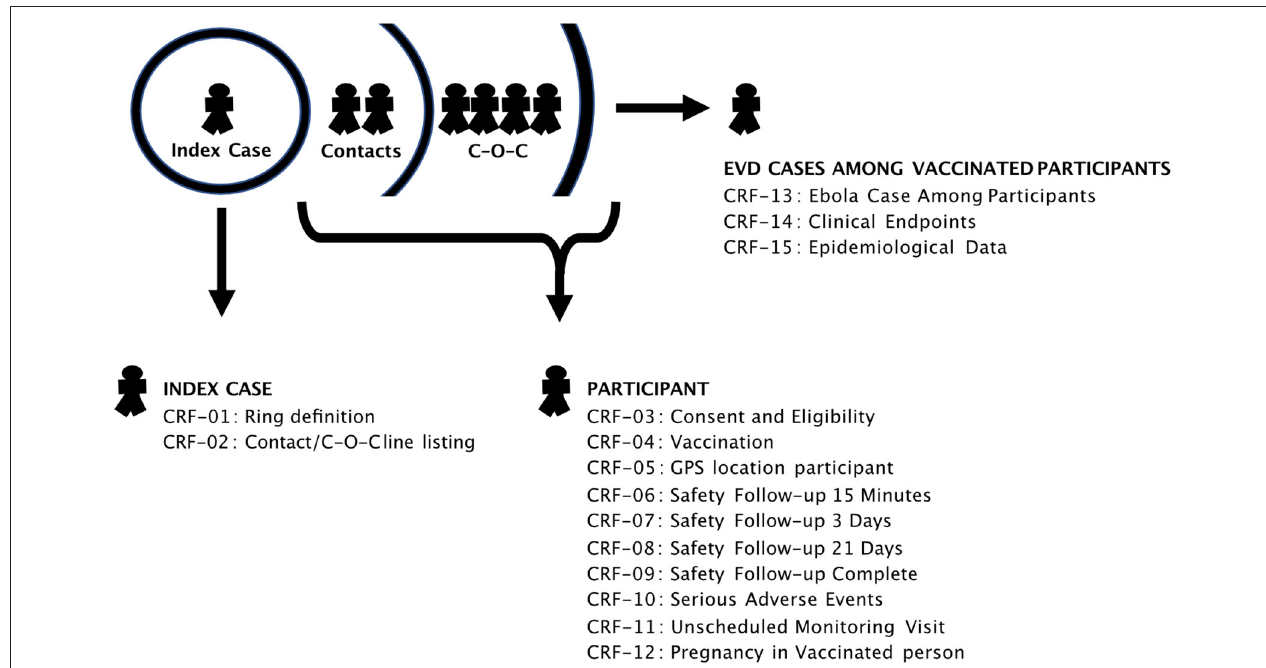
FIGURE 1 | Data capture points within the Ebola Vaccination implementation. Individual CRFs captured information at differing points within the programme. Unique participant IDs were recorded at each point to allow downstream data-linkage.